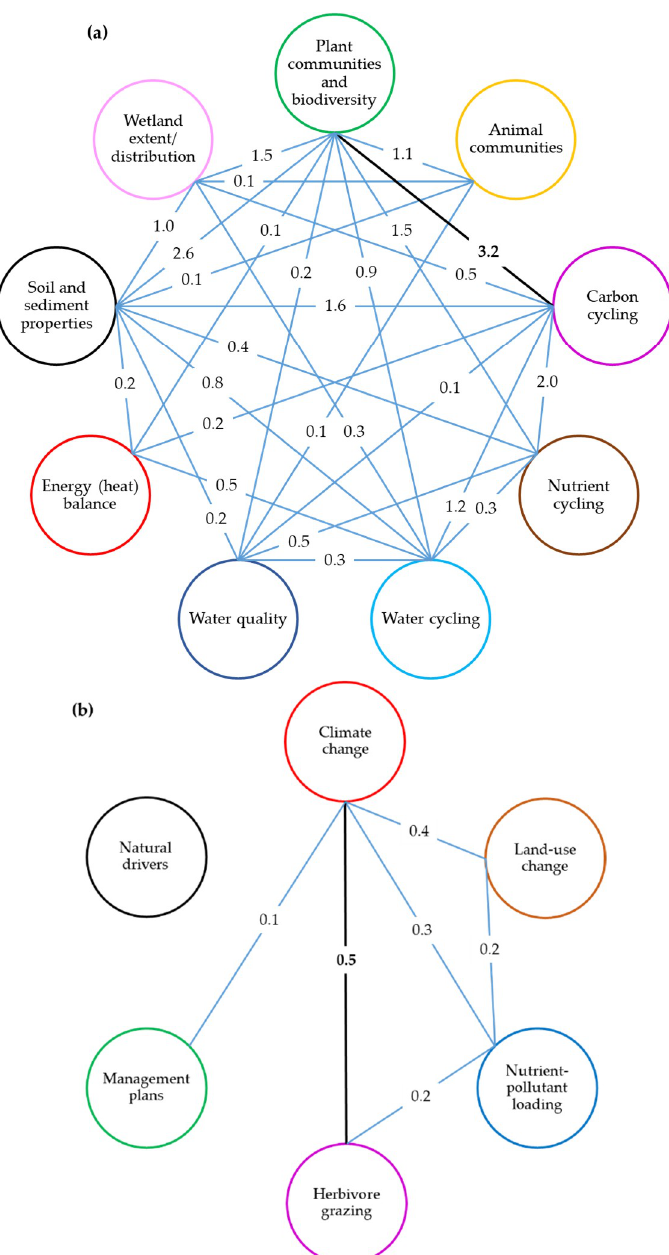
Figure 4. Combinations of investigated ( a ) wetland-related landscape characteristics, regardless of drivers; ( b ) drivers of changes in wetland landscapes, regardless of characteristics. All values are percent (% of total 893 studies). Black lines as connections between characteristics (change drivers) with bold numbers illustrate the highest frequency of investigation (corresponding % number) among all studied combinations of landscape characteristics (change drivers). (For interpretation of the colors in this figure, the reader is referred to the web version of the